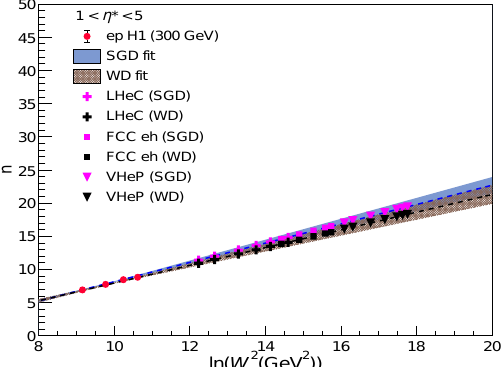
Figure 15. Mean multiplicity (cid:104) n (cid:105) versus ln ( W 2 ) dependence for ep collisions [33]. Experimental values are compared with the predicted values from the SGD and WD models. Shown also are the (cid:104) n (cid:105) expected at the future proposed high energy ep colliders.